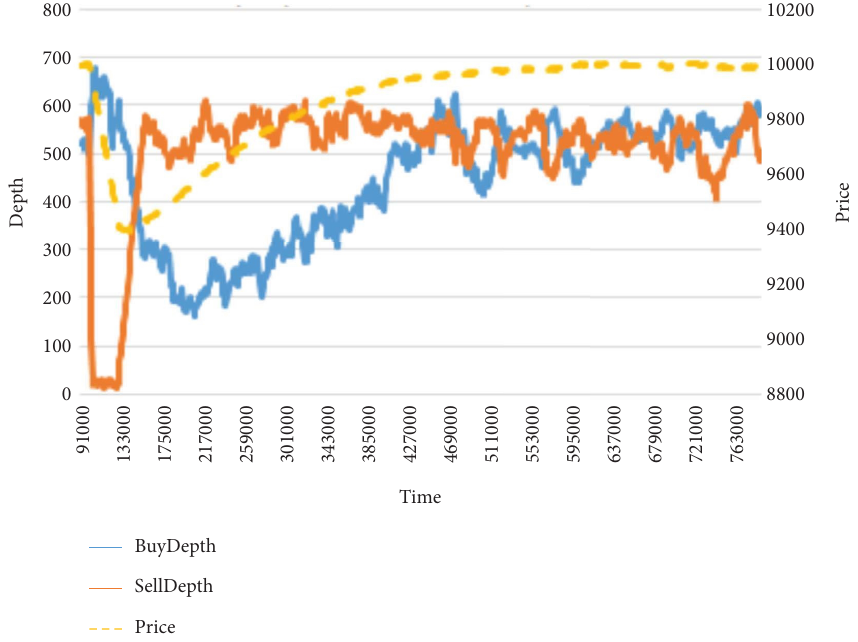
Figure 6: Price and depth in the unstable